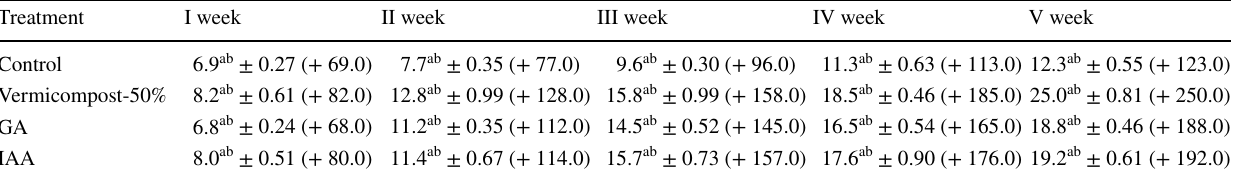
Table 5 Effect of vermicompost and PGRs on the number of branches ( n ) of C. annum